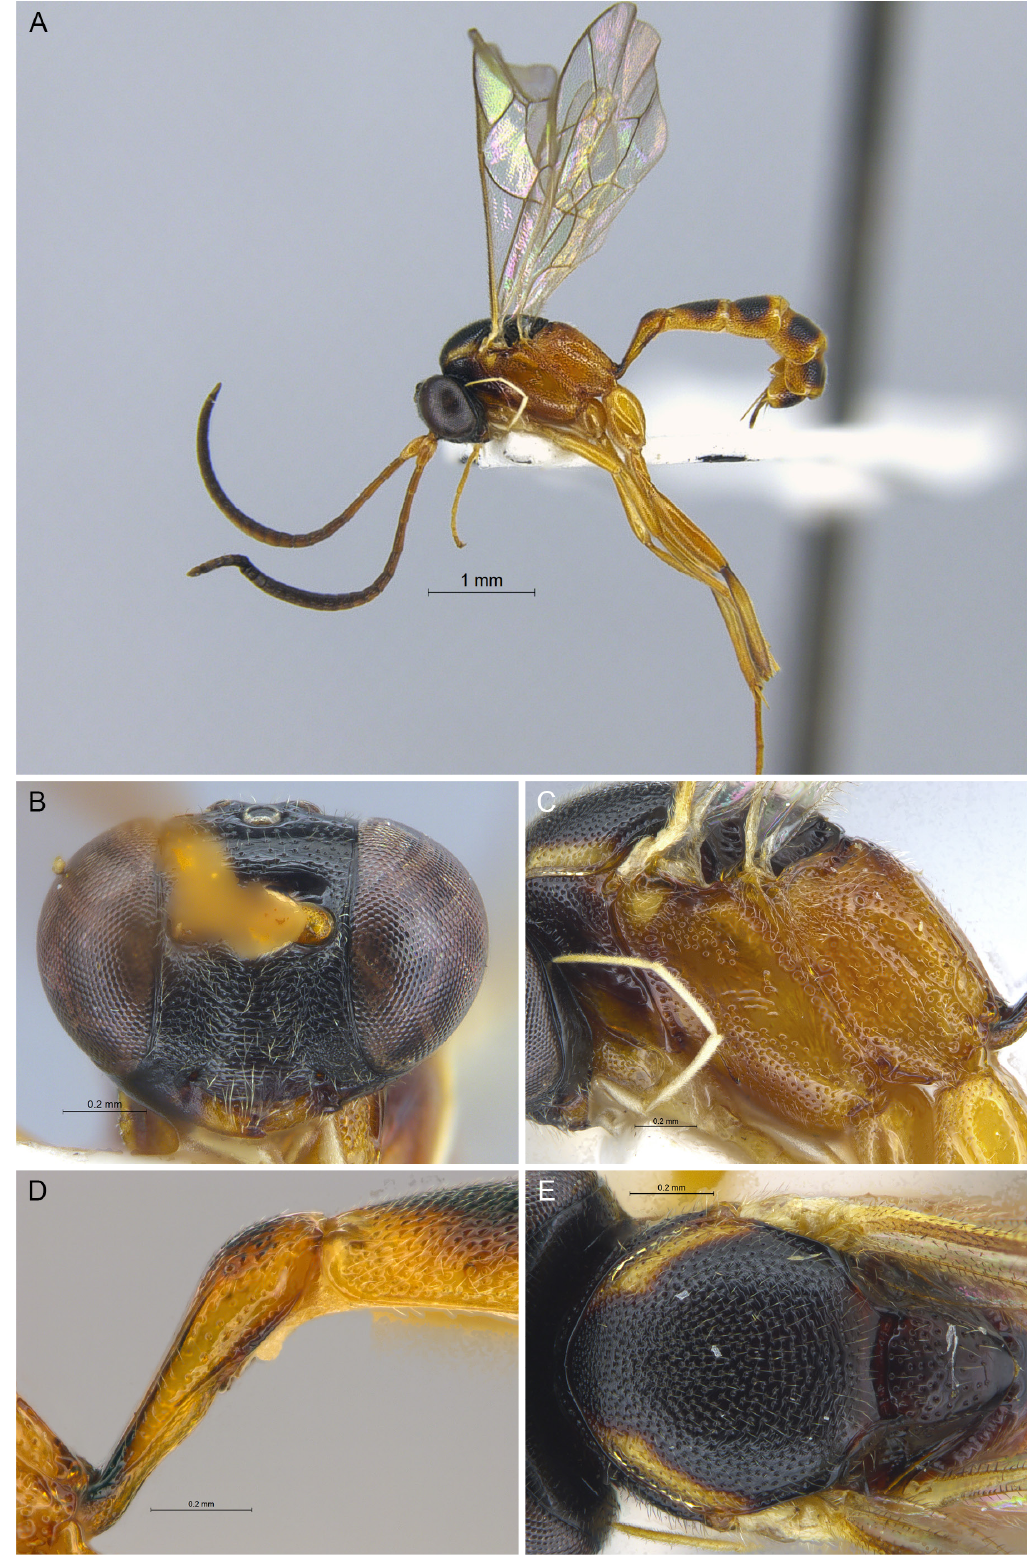
Fig. 20. Palpostilpnus trifolium sp. nov., holotype, ♀ (NHRS HT-HEVA000010861). A . Lateral habitus. B . Head, anterior view. C . Mesopleuron. D . T1, lateral view. E .